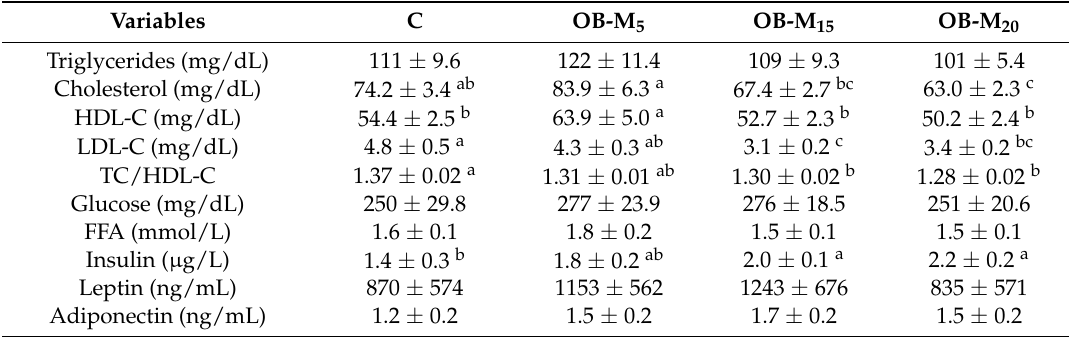
Table 4. Plasma parameters of hamsters with diet-induced obesity fed the experimental oil for eight weeks.